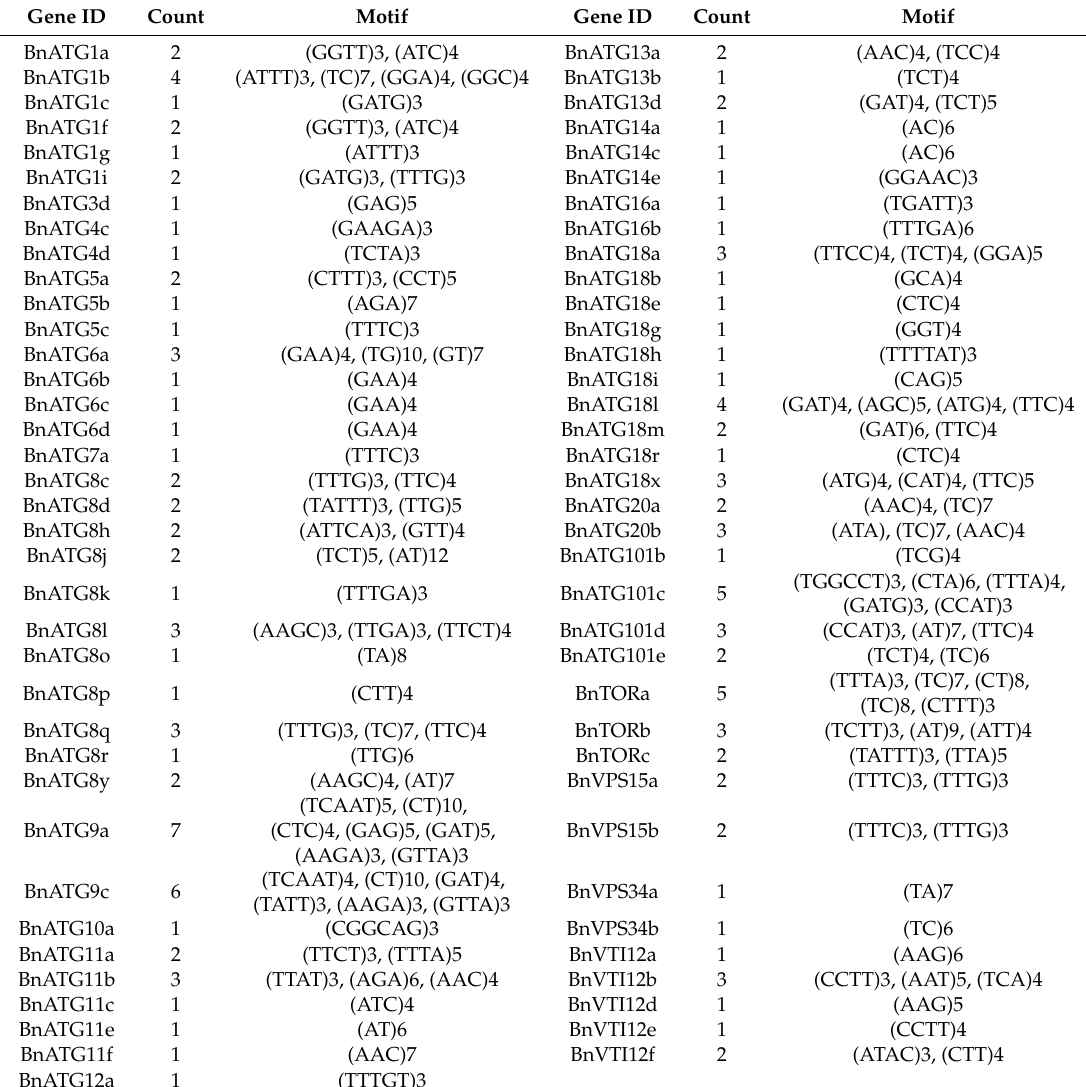
Table 1. Simple sequence repeats detected in